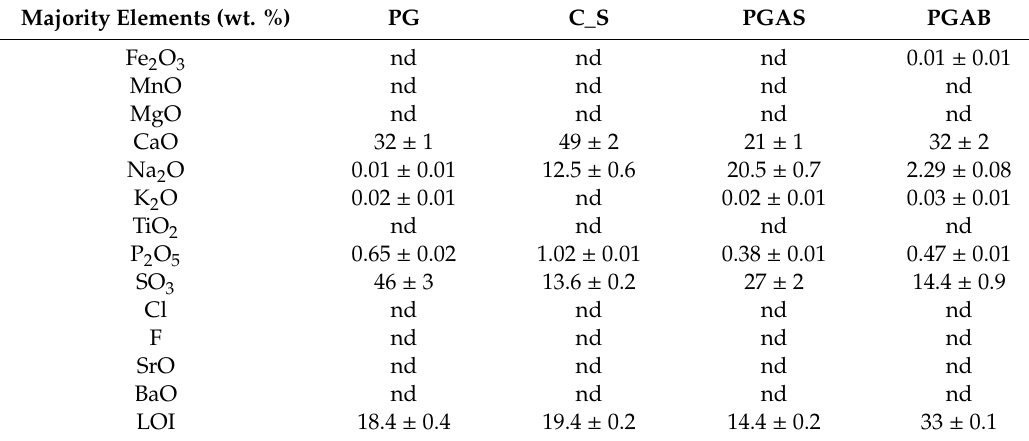
Table 1. Majority elements in both chemical processes.